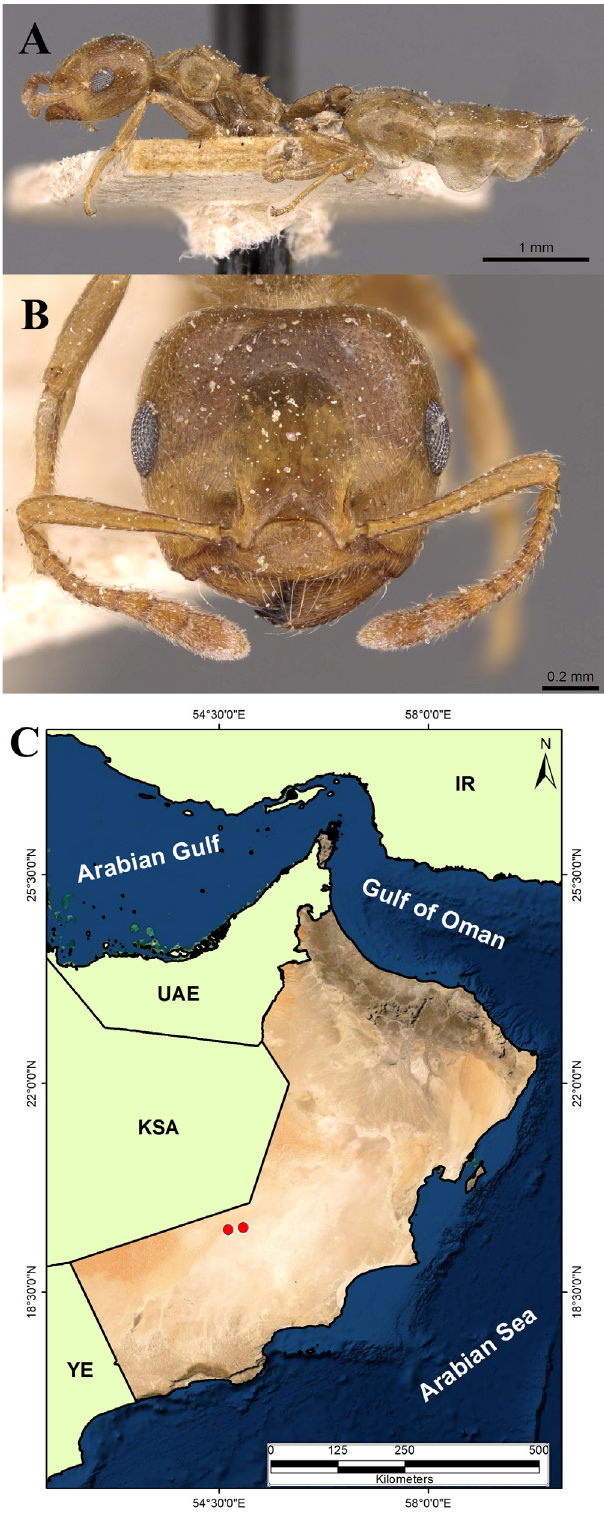
Fig. 30. Crematogaster acaciae Forel, 1892, syntype, worker (CASENT0908494, AntWeb.org (Zach Lieberman)). A . Body in profile. B . Head in full-face view. C . Distribution